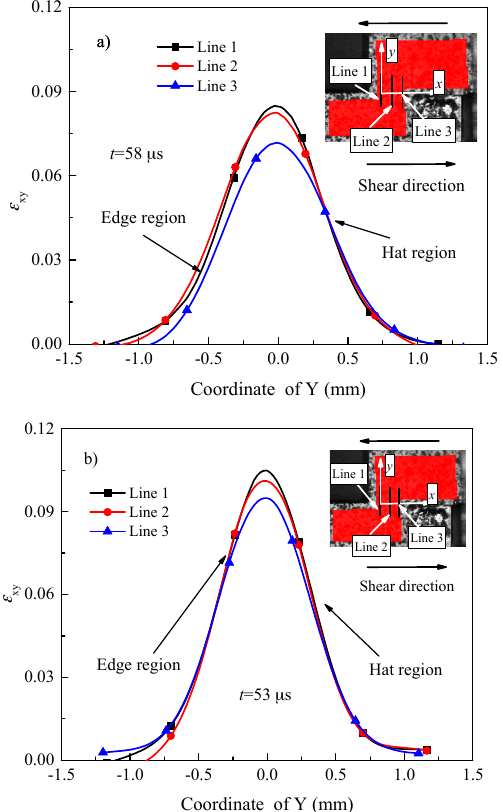
Figure 7. Distribution of shear strain for different positions along the shear region for ( a ) Ti-64 alloy at 58 µ s, and the velocity of the striker bar is equal to 9.2 m/s; ( b ) Ti-55511 alloy at 53 µ s, and the velocity of the striker bar is equal to 9 m/s. The center of shear region is defined as x axis, and y axis is perpendicular to the shear